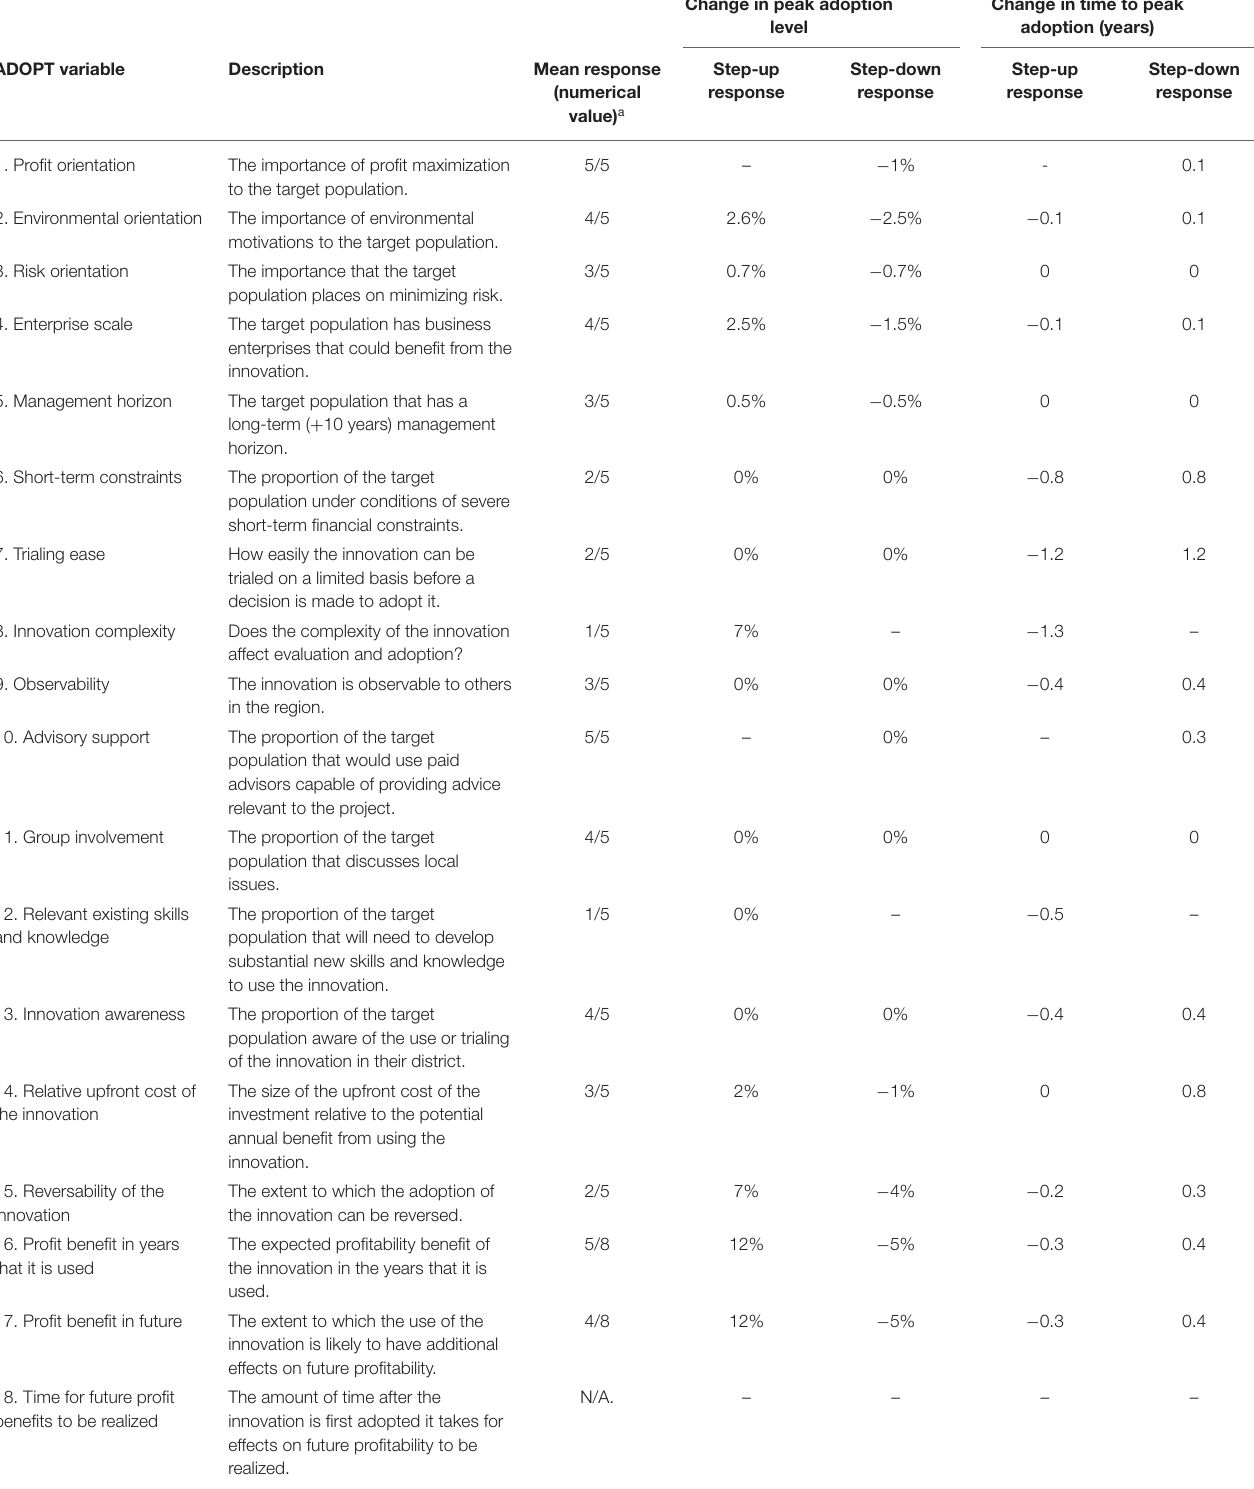
Change in peak adoption Change in time to peak level adoption (years)